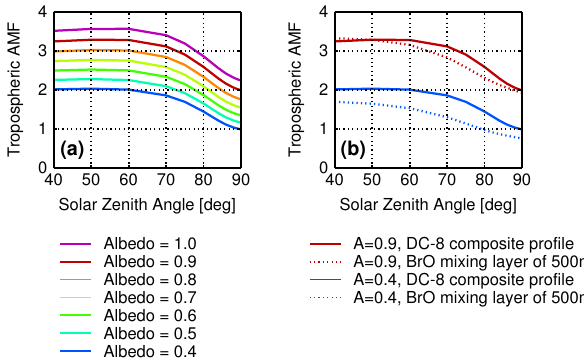
Albedo = 0.4Albedo = 0.5Albedo = 0.6Albedo = 0.7Albedo = 0.8Albedo = 0.9Albedo = 1.0 A=0.4, BrO mixing layer of 500mA=0.4, DC-8 composite profileA=0.9, BrO mixing layer of 500mA=0.9, DC-8 composite profile Fig. 4. (a) Tropospheric air mass factors (AMFs) at 344.6nm computed using the DC-8 composite BrO profile for various surface albedos as a function of SZA; (b) similar to (a) but also showing AMFs found assuming all of the BrO is below 500 m (dotted lines). A refers again to surface albedo.